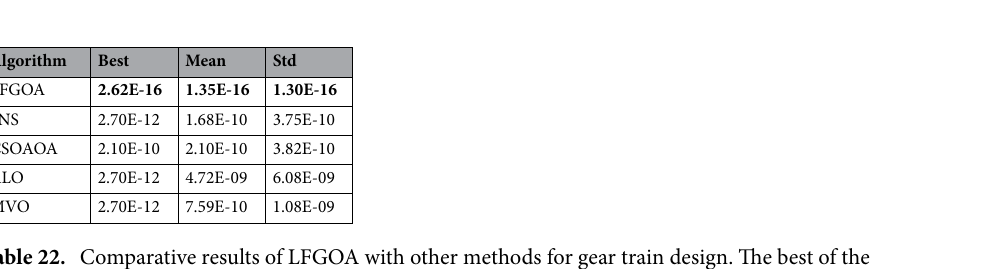
Table 22. Comparative results of LFGOA with other methods for gear train design. The best of the comparison results are in [bold].